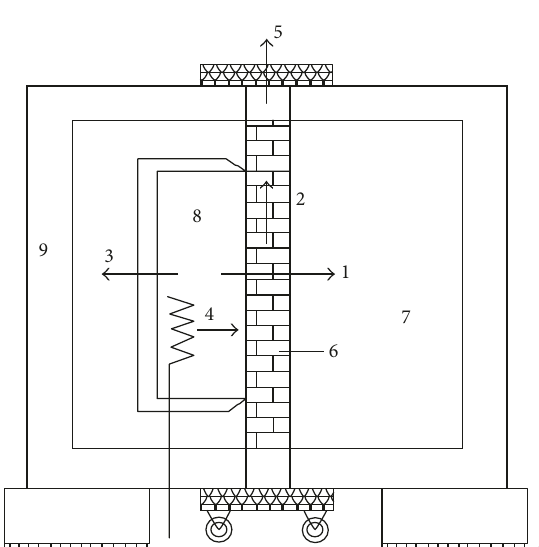
Figure 2: Environment control climate apparatus system. 1 refers to the heat flow through the samples; 2 refers to the uneven heat flow that is parallel to samples; 3 refers to the heat flow through the metering tank; 4 refers to the total input power; 5 refers to sur- rounding heat loss and the heat flow through the sample’s boundaries; 6 refers to the sample; 7 refers to the cold chamber; 8 refers to the metering tank; 9 refers to the protective housing of the environment control climate